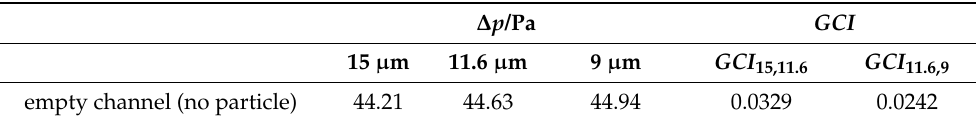
Table 1. The results of the grid convergence study and corresponding grid convergence index ( GCI ) values. A base cell size of 11.6 µ m was chosen as a compromise between the duration of the simulations and their accuracy.